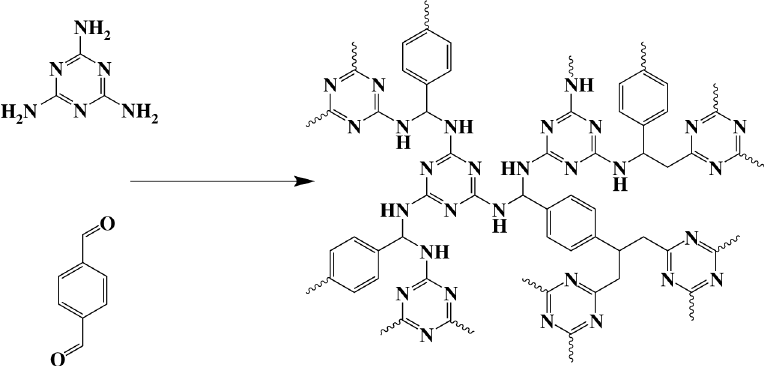
Figure 14: Synthesis and structure of